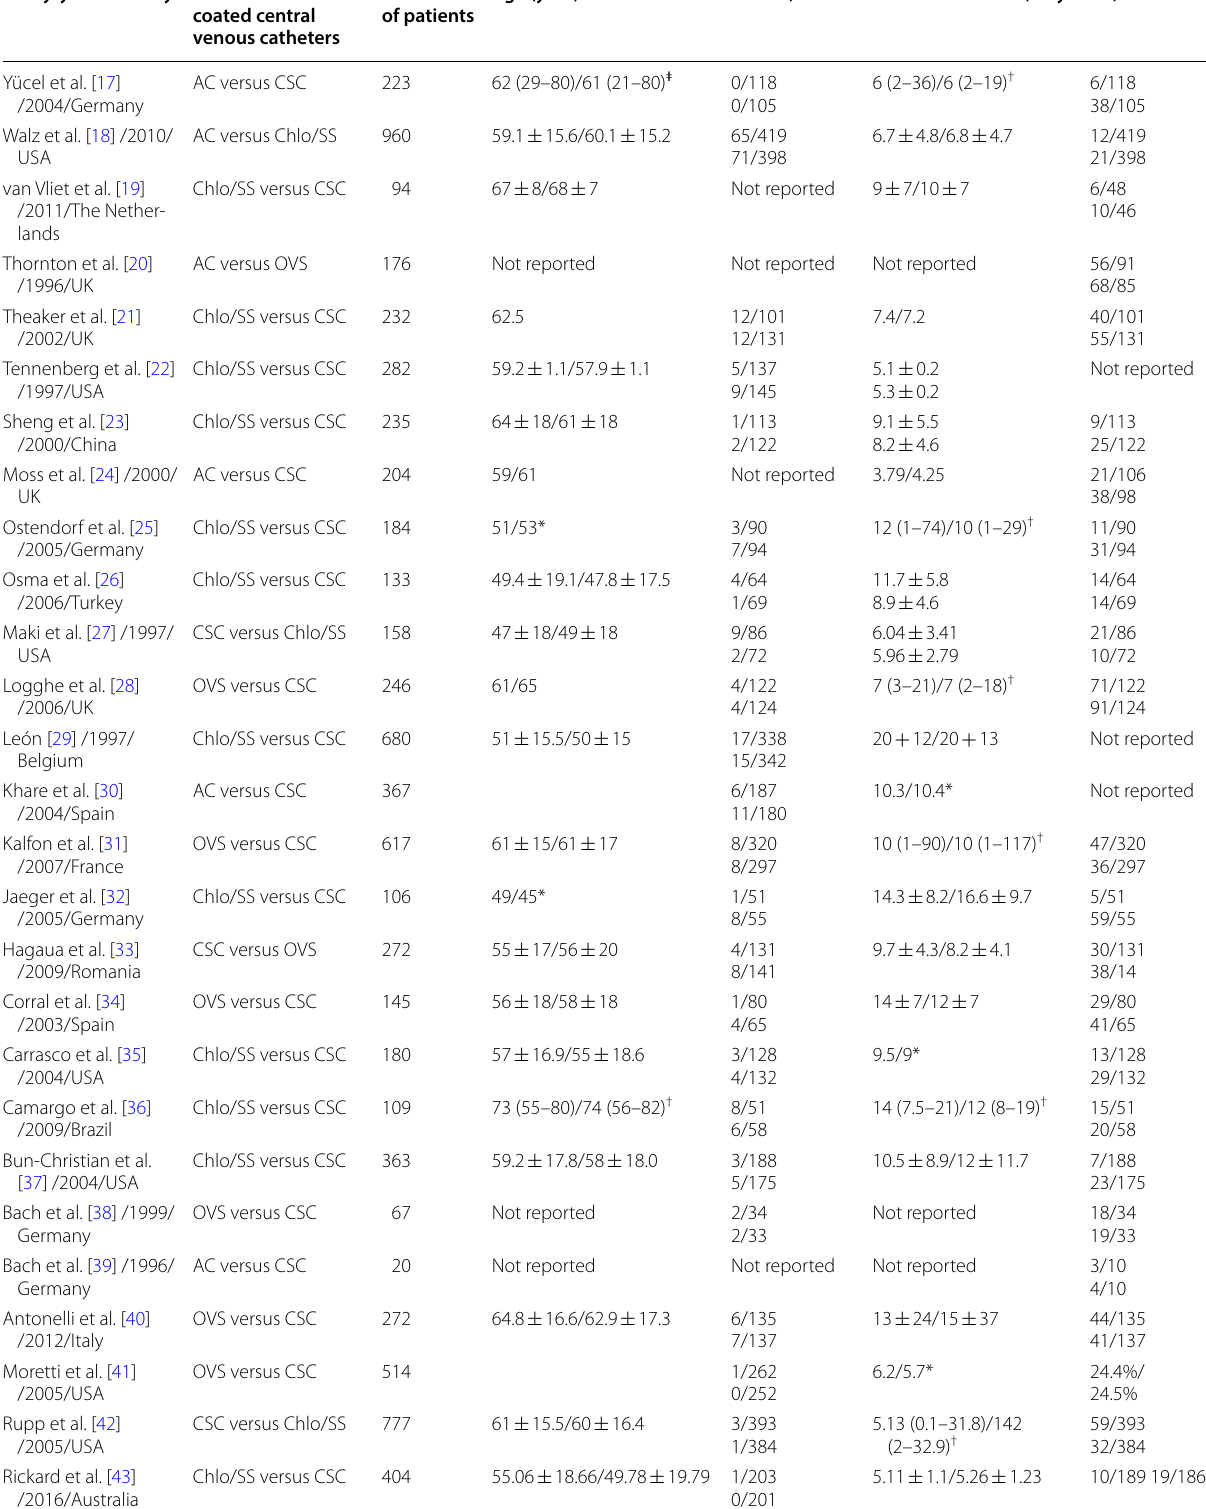
Table 1 Characteristics of the randomized controlled trials Study/year/Country Antimicrobial‑ coated